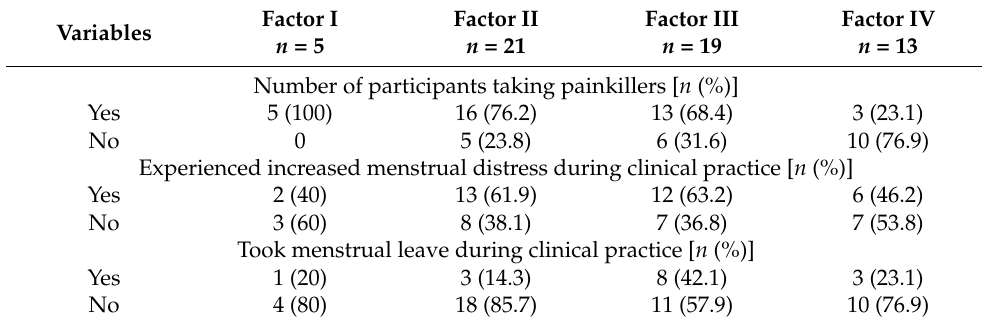
Table 3. Background information of the students within each of the four